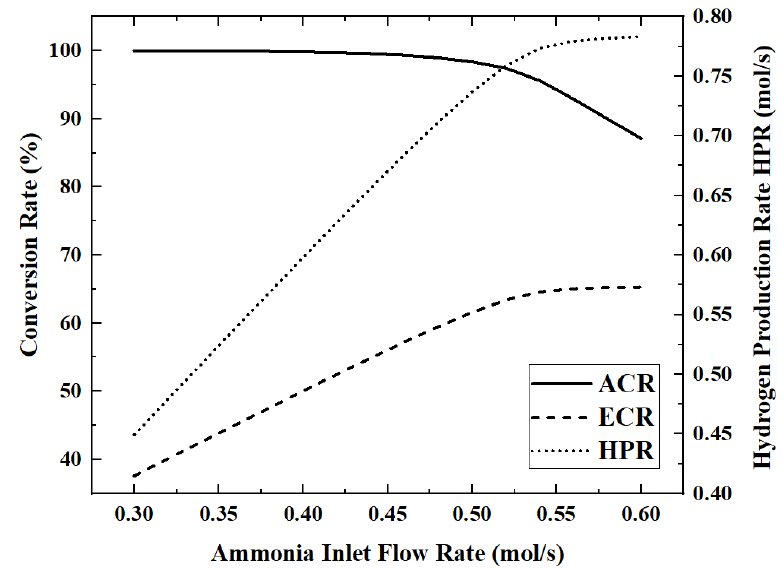
Figure 8. Effect of ammonia flow rate on ACR, ECR and HPR.